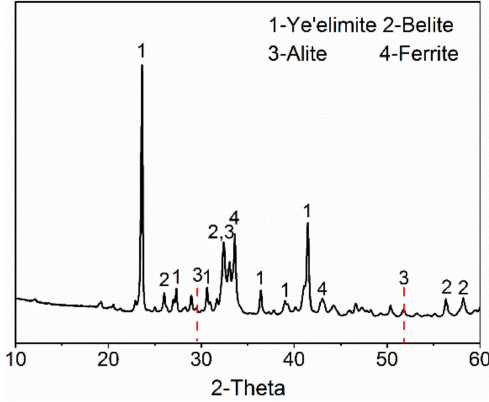
Figure 1. XRD pattern of AMCSA